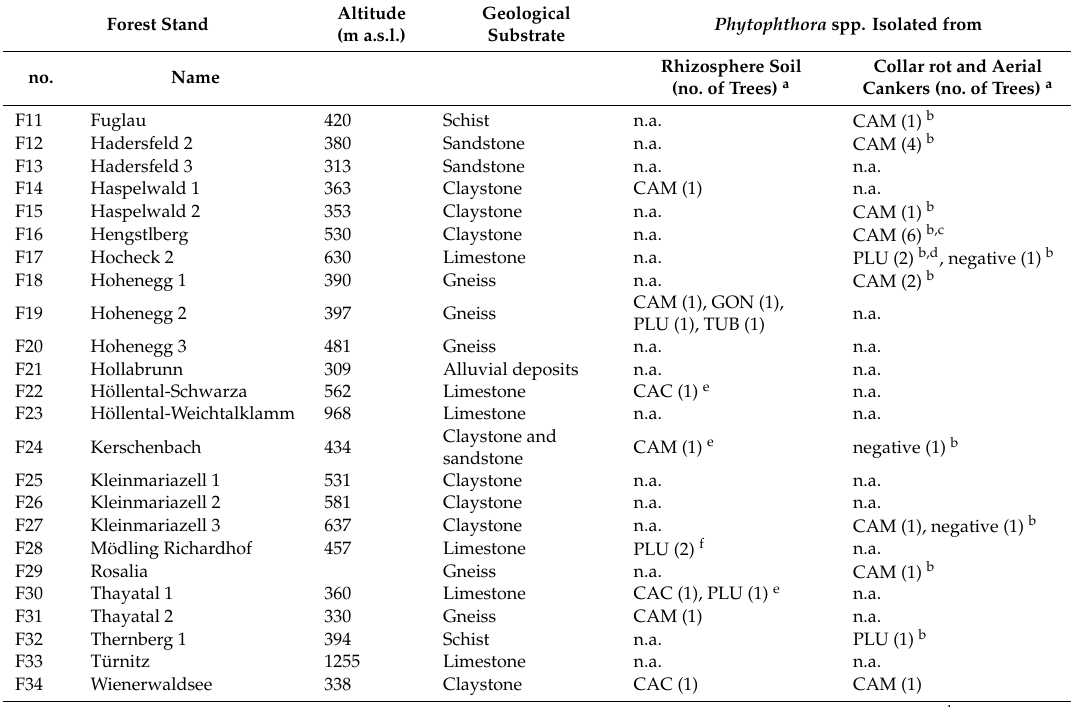
Table 2. Isolation of Phytophthora species from rhizosphere soil samples and bleeding bark cankers of declining and non-declining mature beech trees in 24 extensively surveyed forest stands in Lower Austria. Altitude Geological Phytophthora spp. Isolated from Forest Stand (m a.s.l.) Substrate Collar rot and Aerial Rhizosphere Soil no. Name Cankers (no. of Trees) (no. of Trees) a